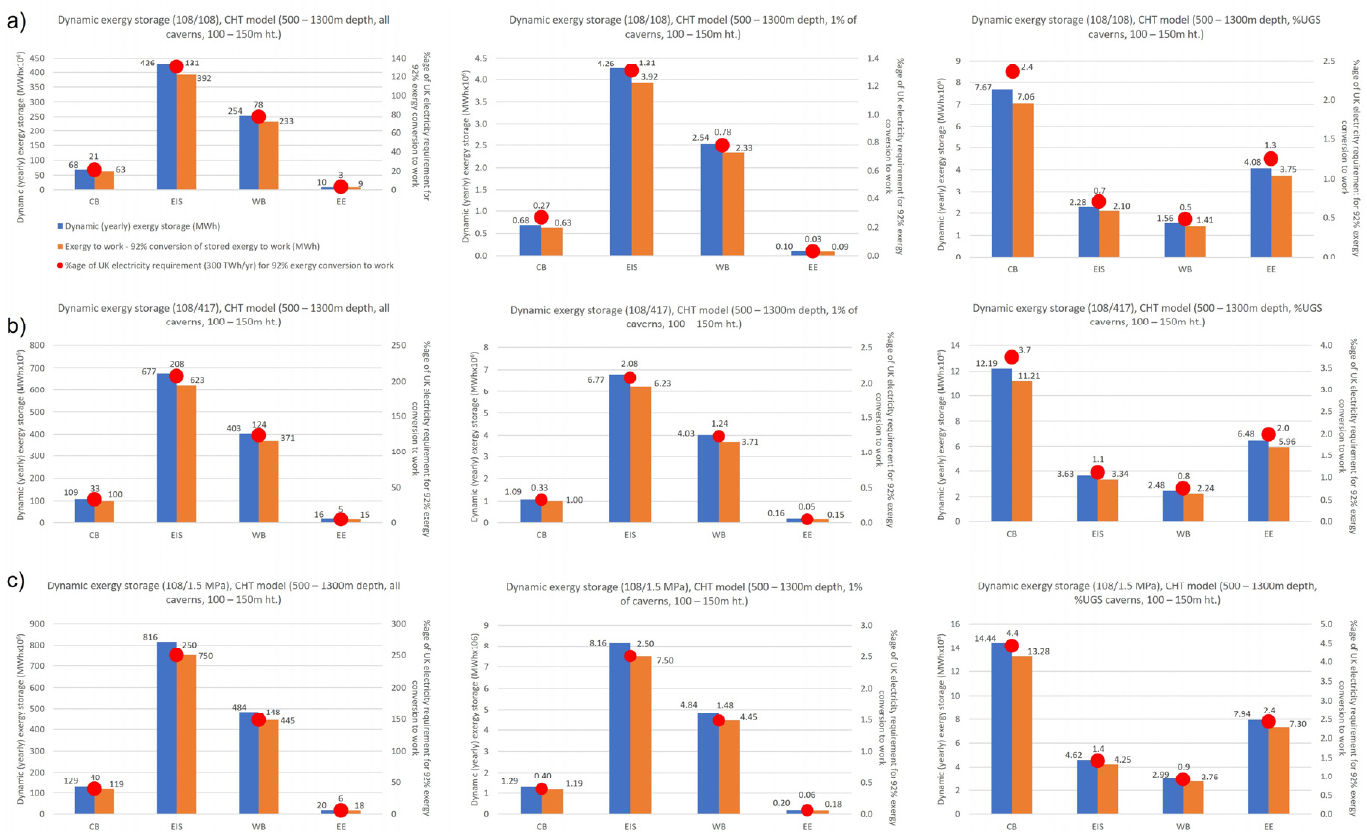
7 Figure 7. Plots of dynamic exergy storage and exergy to work estimates for the preferred CHT model, over the depth range 500–1300 m and cavern heights 100–150 m considered for CAES. Parts ( a – c ) show graphs for differing injection/withdrawal rates (108/108 kg/s and 108/417 kg/s) or fill and pressure reduction rates (108 kg/s/1.5 MPa/h) for all potentially available caverns, 1% of available caverns and estimates based upon the number of UGS caverns in the basins. Additionally shown, by basin, the percentage of UK electricity demand for 92% of stored exergy to work. Key common to all, see Figure